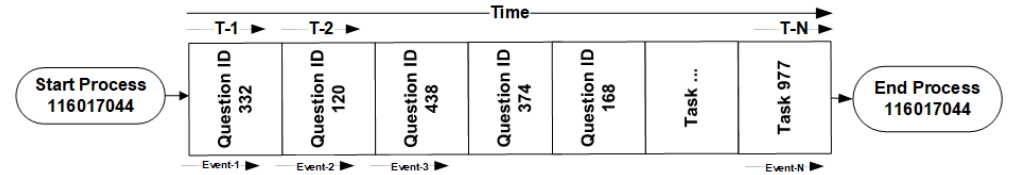
Figure 7. Sample flow of events in CDP.